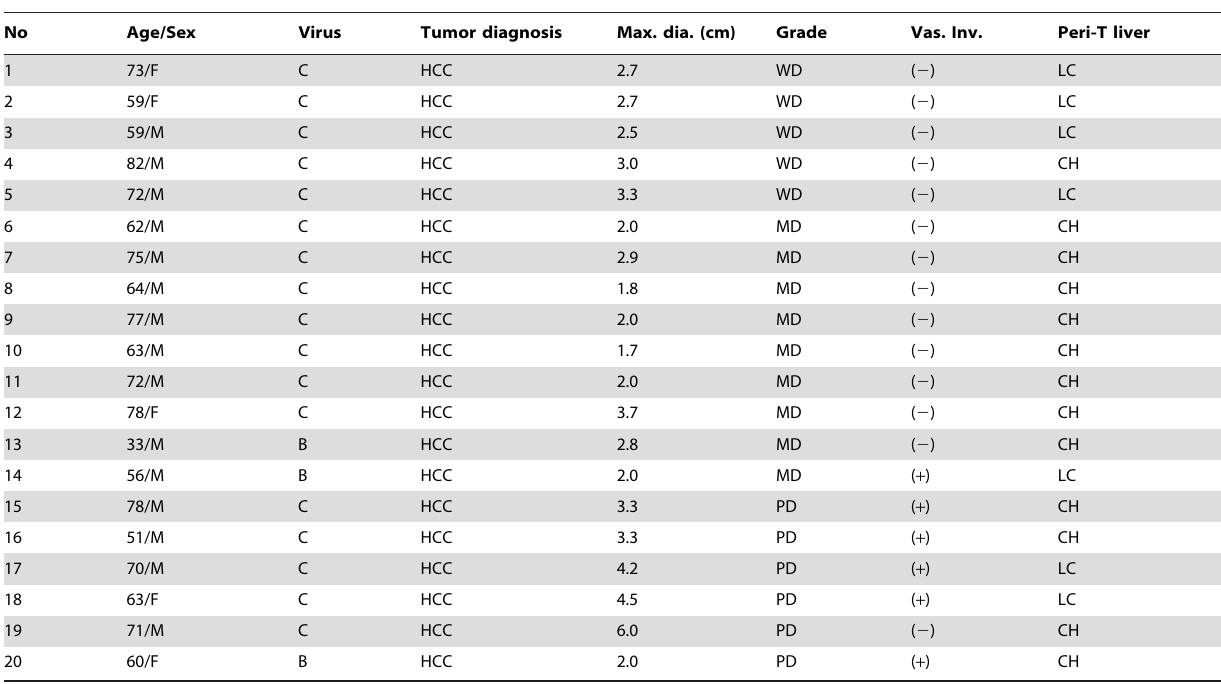
Table 2. Patient and tumor characteristics in Japanese patients.